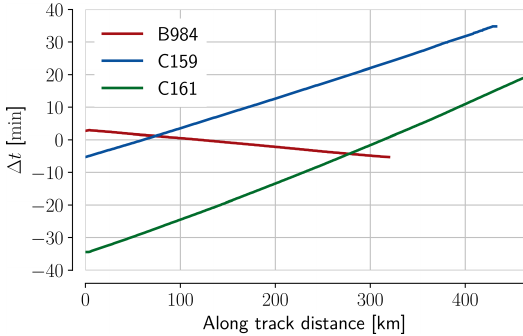
Figure 3. Delays between the co-located observations from radar and radiometers for the three